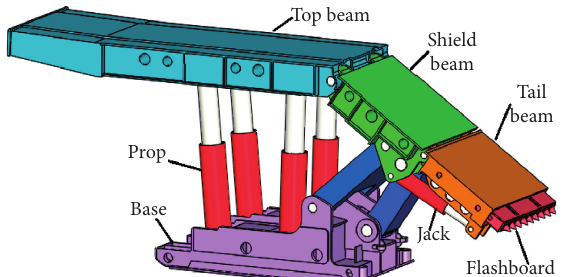
Figure 1: Assembly body of the top coal caving hydraulic